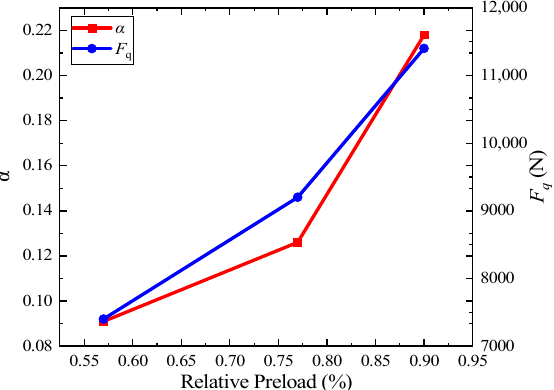
Figure 10. Parameters altering with the relative preload.